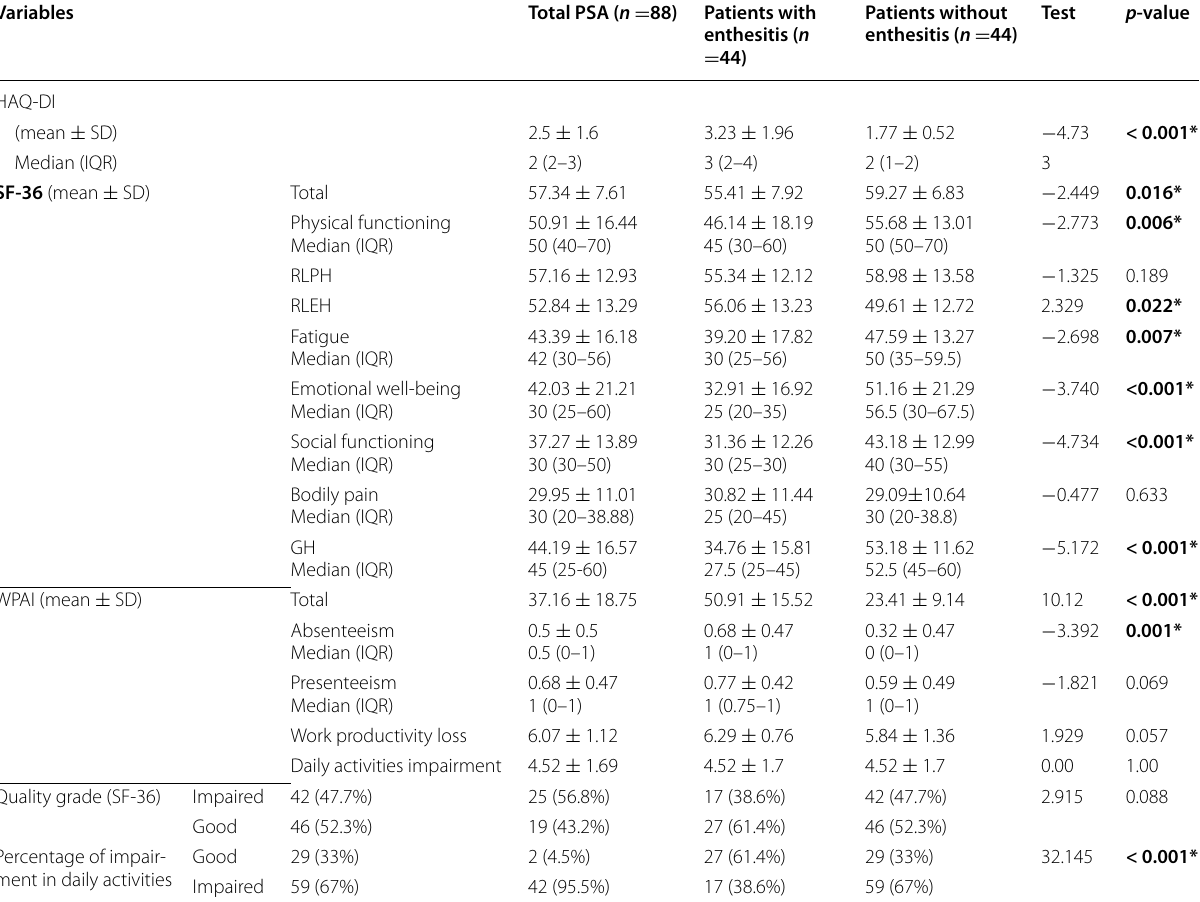
Table 3 Quality of life of patients suffering from psoriasis-related enthesitis and those without